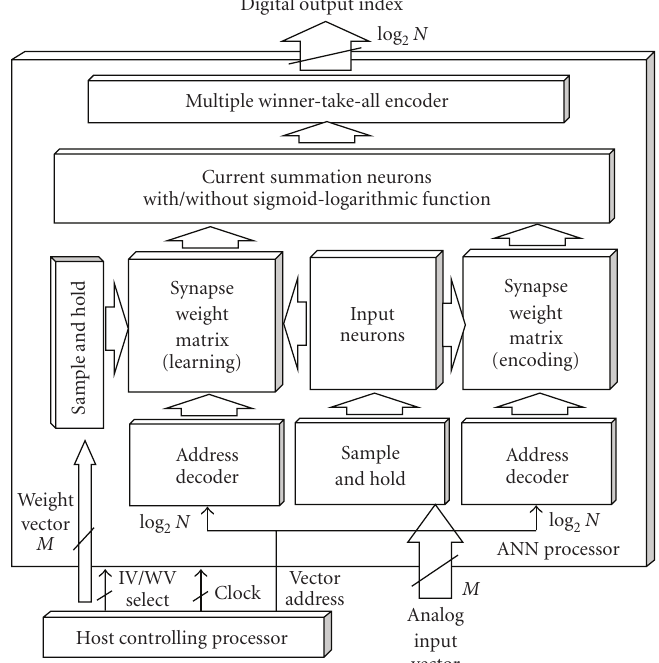
Figure 5: A system-on-chip architecture design for the winner-take-all selforganization artificial neural network chip.